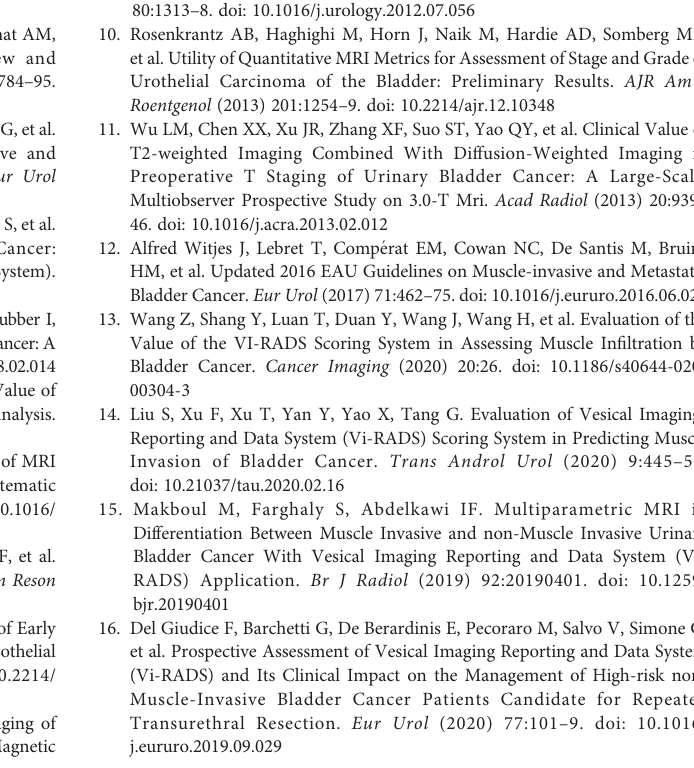
Supplementary Figure 1 | Inclusion and exclusion criteria and recruitment pathways for patients in this study. MRI, magnetic resonance imaging. Supplementary Figure 2 | The coef fi cients and formula of the radiomics signature. (A) Histogram showing the coef fi cients of 21 selected features in the radiomics signature. (B) The formula for calculating the radiomics score of each patient. Supplementary Figure 3 | Pairwise Spearman rank correlation among 21 selected features in the training set. Supplementary Figure 4 | Performance of the radiomics score in 52 bladder cancer patients with VI-RADS score of 3. (A) ROC curves of the radiomics score in bladder cancer patients with VI-RADS score of 3. (B) DCA for radiomics score and other clinical factors in bladder cancer patients with VI-RADS score of 3. VI-RADS, Vesical Imaging-Reporting and Data System; ROC, receiver operating curve; AUC, area under the ROC curve; DCA, decision curve